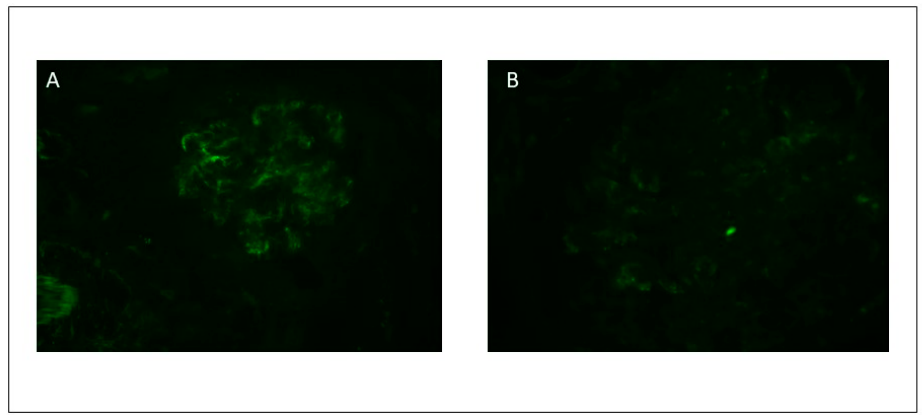
Figure 2. Direct immunofluorescence study showing predominant IgA positivity ( A ) and C3 posi- tivity ( B ) with granular pattern and mesangial distribution.